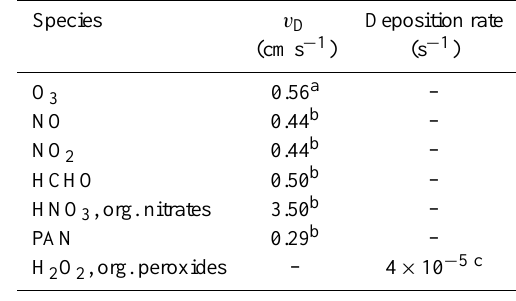
Table 3. Deposition rates/velocities used in the model. Species v D Deposition rate